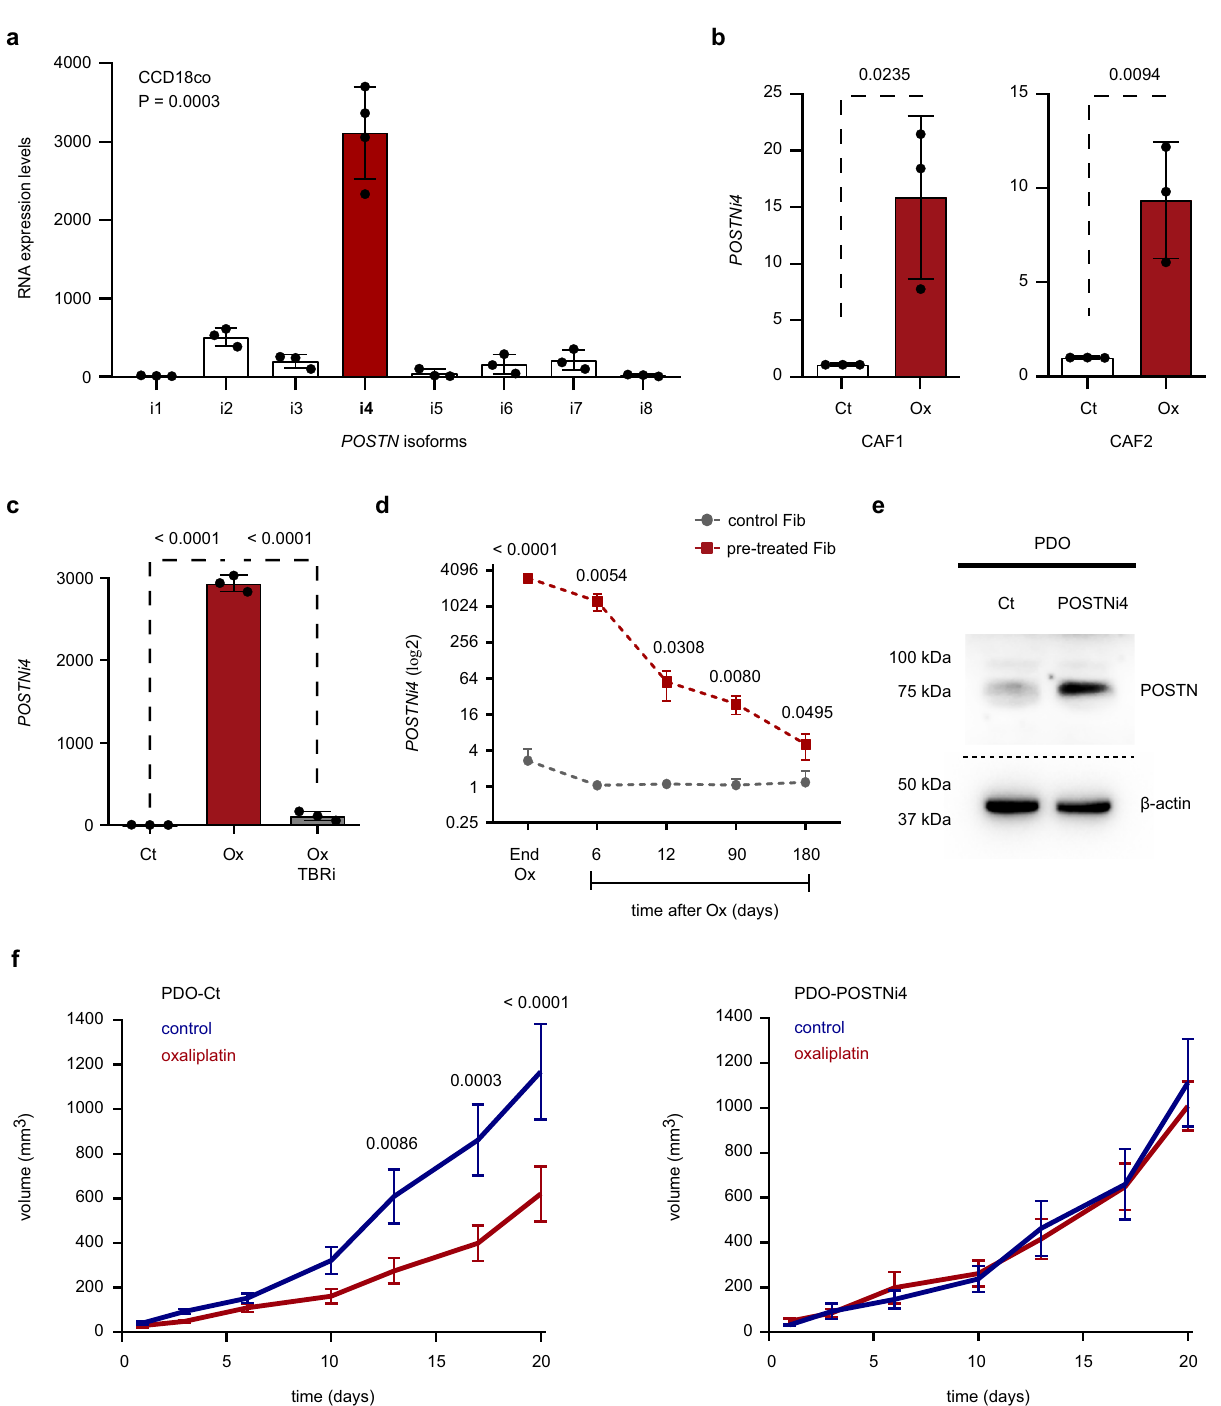
Fig. 7 | Platinum-induced expression of POSTN isoform 4 in the tumor stroma enhancesresistancetotreatment.a Relativeexpressionlevelsof POSTN isoforms in CCD-18Co treated with oxaliplatin. n =4 and n =3 biologically independent experimentsfor POSTNi4 andfor POSTNi1-3,5-8 respectively.Valuesaremean±sd. p value is indicated. b Relative expression levels of POSTNi4 in CAFs treated with oxaliplatin. n =3 biologically independent experiments. Values are mean±sd. p values are indicated. c Relative expression levels of POSTNi4 in CCD-18Co treated with oxaliplatin w/o TGF-beta pathway inhibitor (TBRi). n =3 biologically inde- pendent experiments. Values are mean±sd. p values are indicated. d Relative expression levels of POSTNi4 in CCD-18Co 6, 12, 90, 180 days after